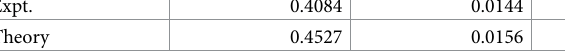
Table 2. Singular values for the molar HU potency matrix (AHU m 3 mol − 1 ). Expt.